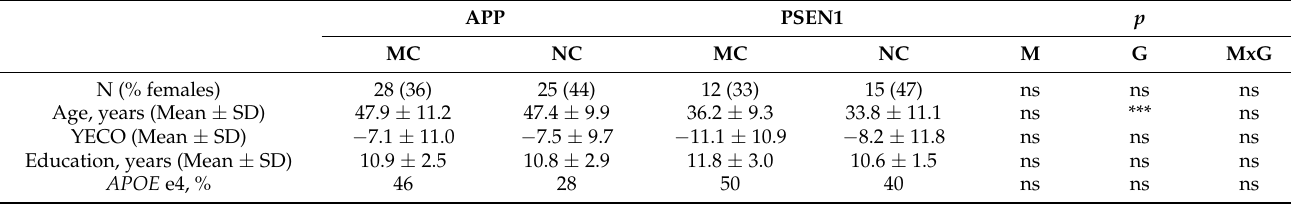
Table 1. Demographic characteristics (age, gender, YECO = years to estimated clinical onset, years of education, % APOE ε 4) of adAD mutation carriers (MC) and non-carriers (NC) from APP and PSEN1 families. There were 12 MC with APP Swedish, 15 with APP Arctic, 1 with APP London, 3 with PSEN1 I143T or M146V and 9 with PSEN1 H163Y mutation. In addition, p -values are reported using two-way (Mutation and Gene) ANOVAs with each background factor as dependent variable. APP PSEN1 p MC NC MC NC M G MxG N (% females) 28